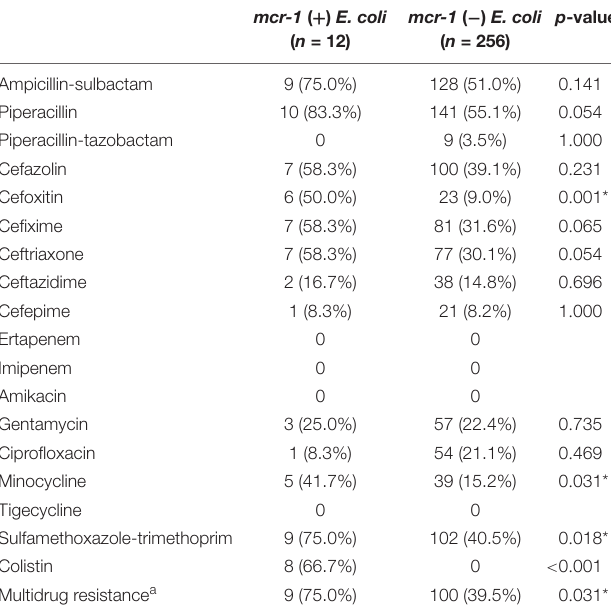
TABLE 3 | Comparing antibiotic resistance profiles between mcr-1 -positve E. coli and non- mcr-1 -positve E. coli. using